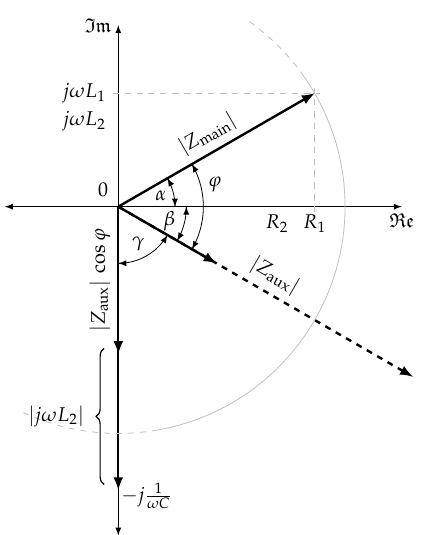
Figure 11. Vector diagram of calculation for a variable phase shift of current.